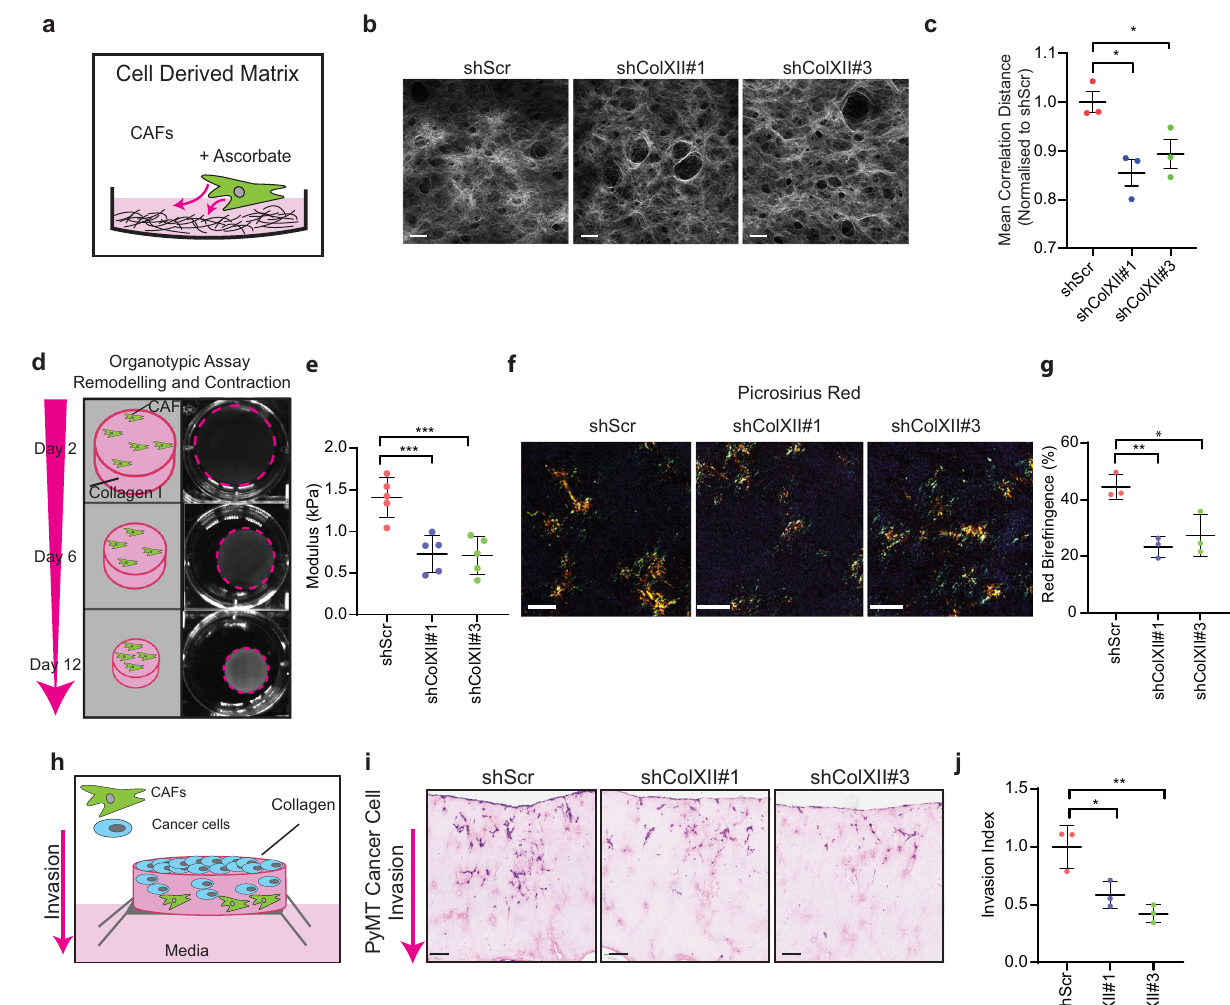
Fig. 6 | Collagen XII knockdown modulates fi brillar collagen architecture and inhibits cancer cell invasion. a Schematic representation of cell-derived extra- cellular matrix (CDM) secreted by cancer-associated fi broblasts (CAFs). b Representative single-plane images of second harmonic generation (SHG) multi- photon signalof CDMsproduced by CAFscrambledcontrol(shScr)and two stable collagen XII knockdown lines (shColXII#1 and #3) from n =3 biologically inde- pendent experiments. c Grey-level co-occurrence matrix (GLCM) analysis of mean correlationdistanceofcollagenIstructureinCAF-derivedCDMsfollowingcollagen XII knockdown. Mean ±SD, n =3 biologically independent experiments, * p <0.05, shScr vs. shColXII#1 p =0.14; shScr vs. shColXII#3 p =0.049; One-way ANOVA with Dunnett ’ s multiple comparisons test. d Schematic representation of 3D organo- typic matrix remodelling by fi broblasts (scale bar=7mm). Representative of n =5 biologically independent experiments. e Bulk modulus (stiffness) of organotypic matrices remodelled by control (shScr) or collagen XII knockdown (shColXII#1, shColXII#3) CAFs at day 12 as measured by uncon fi ned compression analysis. Mean±SD, n =5 biologically independent experiments, *** p <0.001, shScr vs. shColXII#1 p =0.0006; shScr vs. shColXII#3 p =0.0008; one-way ANOVA with a